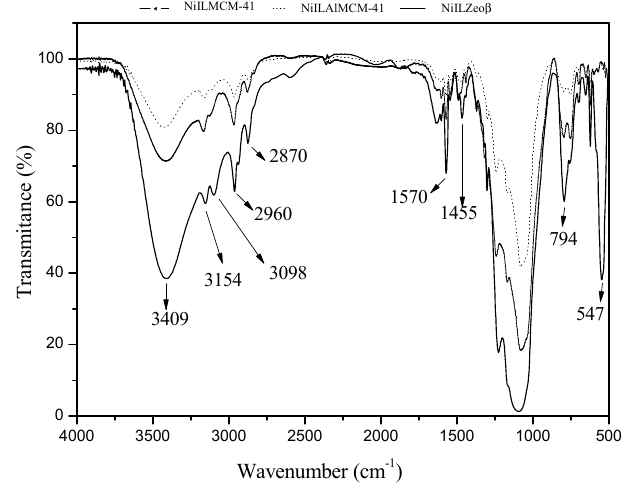
Figure 2. Infrared spectra of NiIL-Zeo β , NiIL-MCM-41 and NiIL-Al-MCM-41.